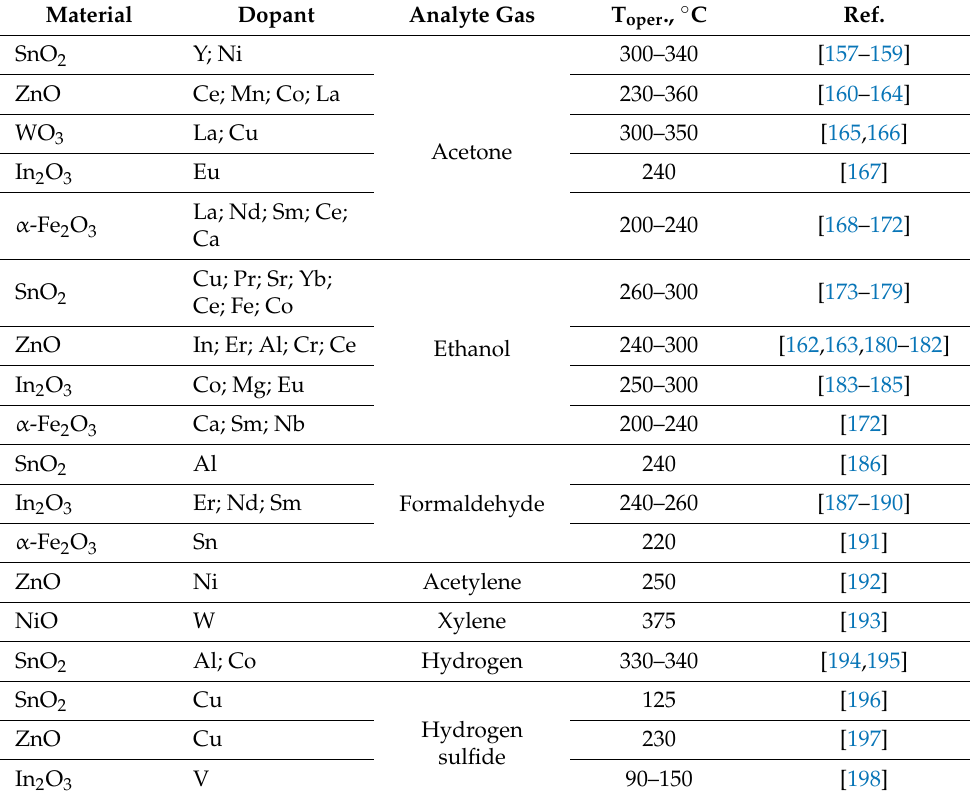
Table 6. Dopants used for optimization of nanofiber-based gas sensors’ response to specific analyte